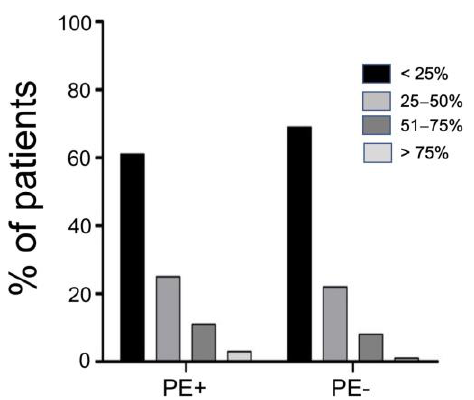
Figure 2. Total severity score (TSS) for PE + and PE − patients. p = 0.054 by χ² test.